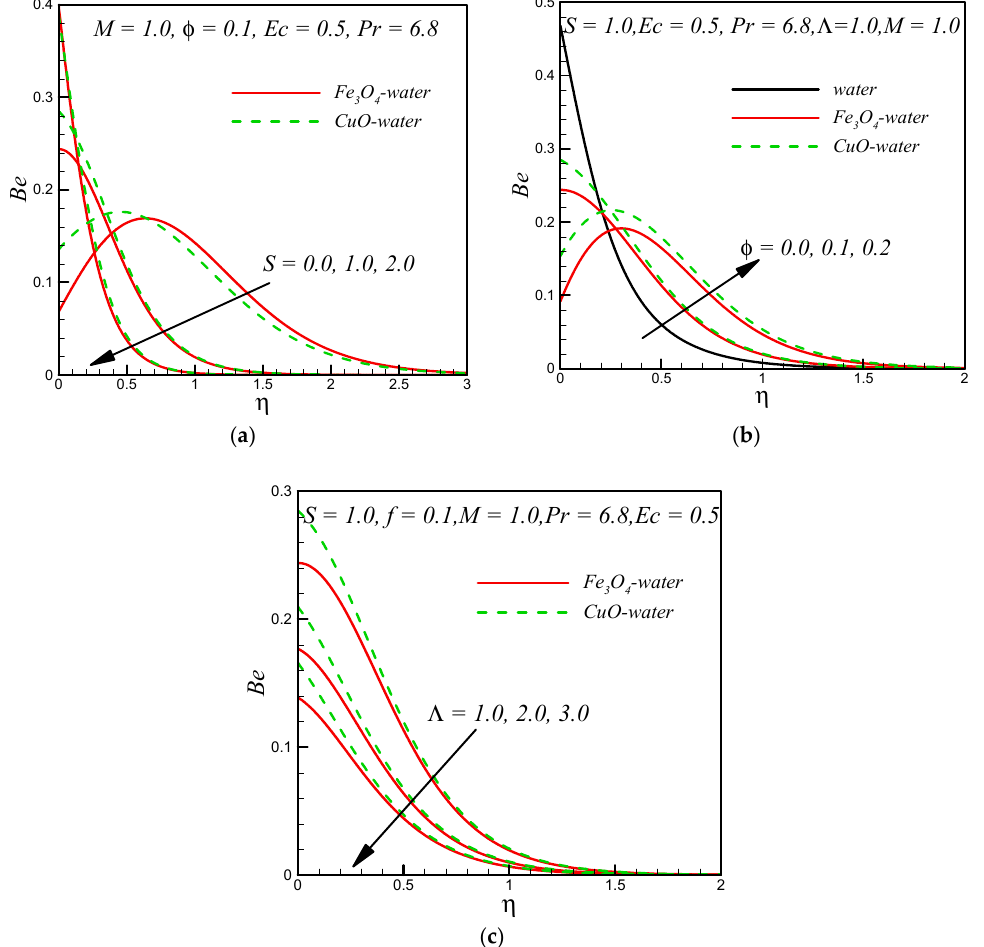
Figure 5. Variation of Bejan number 𝐵𝑒(𝜂) with ( a ) 𝑆 , ( b ) 𝑀 and ( c ) 𝜙 .